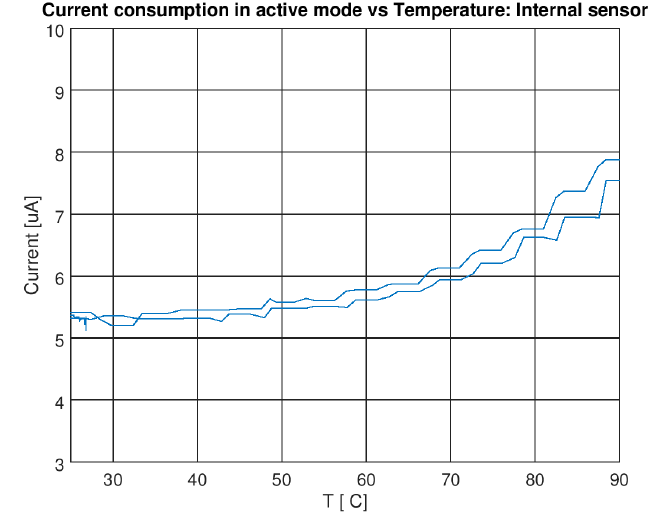
Figure 5. Effects of the temperature over current consumption in active